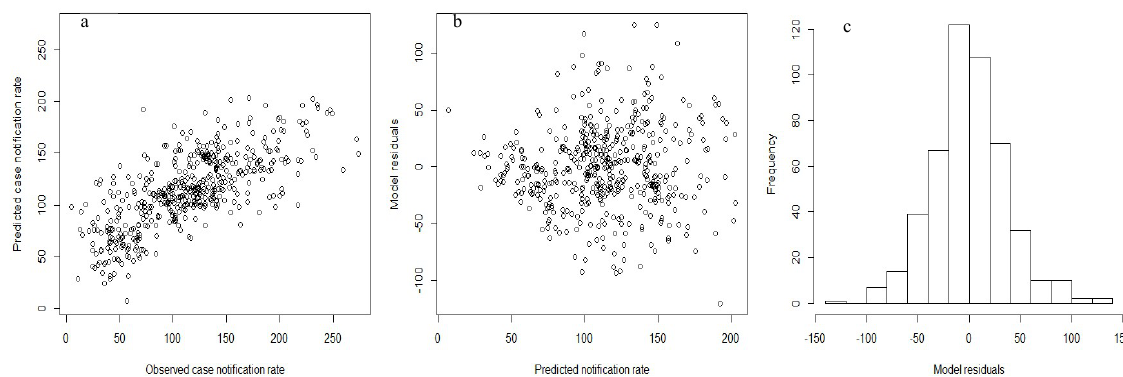
Figure 3. Diagnostic plots showing the goodness of fit of the model to the observed case notification rates. The plots show ( a ) the observed versus the predicted case notification rates ( b ) the predicted case notification rates versus the residual rates and ( c ) a histogram of the model residuals.